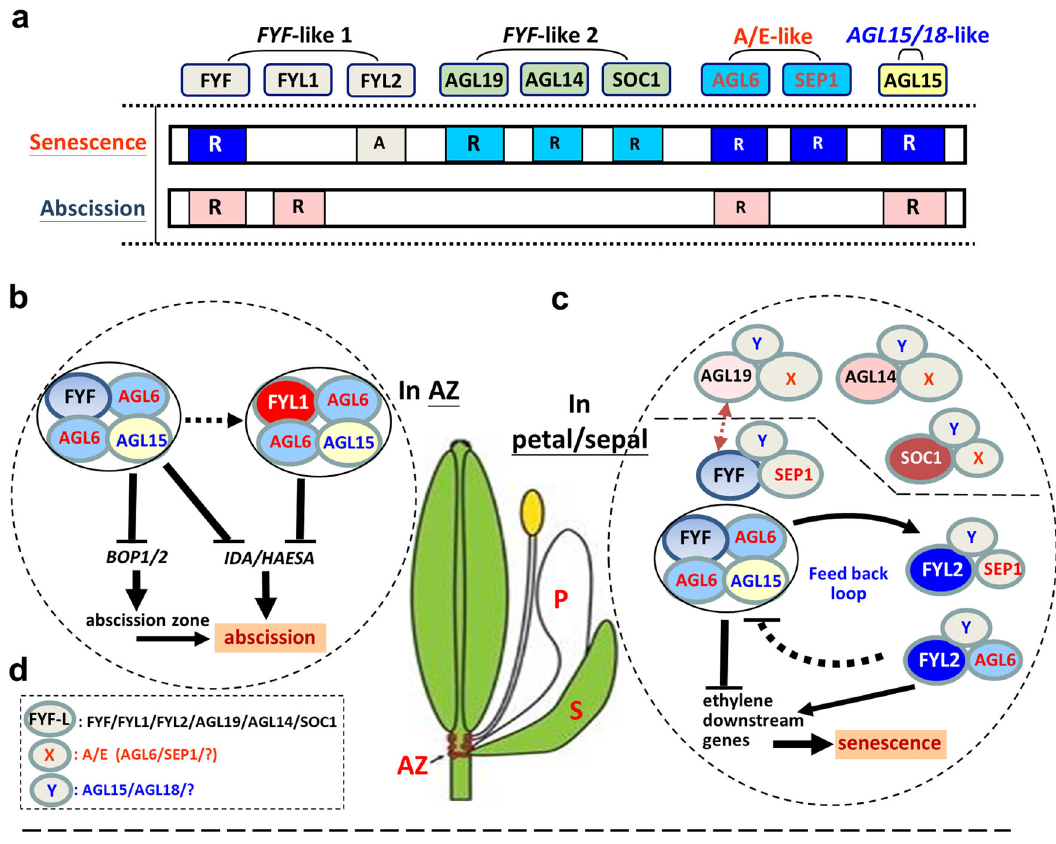
Fig. 5 The functional evolution and regulatory network of the FYF -like genes in regulating fl ower senescence/abscission. a In Arabidopsis , six FYF -like genes in two subgroups ( FYF/FYL1/FYL2 and AGL19/AGL14/SOC1 ) were all involved in regulating fl ower senescence and/or abscission. In the FYF subgroup, FYF acts as a repressor (R) in suppressing both fl ower senescence (indicated by a blue box) and abscission (indicated by a pink box), and FYL1 acts as a repressor (R) and only suppresses fl ower abscission (indicated by a pink box). FYL2 functions as an activator (A) in promoting fl ower senescence (indicated by a gray box). In the SOC1 subgroup, AGL19, AGL14, and SOC1 function as repressors (R) and have only one function in suppressing fl ower senescence (indicated by a light blue box), with the effect of AGL19 being stronger than that of AGL14/SOC1 . In addition, the A/E functional genes AGL6/ SEP1 and AGL15/18 -like gene AGL15 (as a repressor) can regulate senescence (indicated by a blue box) by interacting with FYF/FYL2, whereas AGL6 and AGL15 can also regulate abscission (indicated by a pink box) by interacting with FYF/FYL1. The size of the letter R in the box correlated with the strength of the repressor for the MADS box proteins. b In the AZ of the perianth, FYF and FYL1 complement each other by forming two identi fi ed heterotetrameric abscission complexes, FYF/AGL6/AGL6/AGL15 and FYL1/AGL6/AGL6/AGL15, suppressing fl ower abscission through the downregulation ( ⊣ ) of BOP1/2 and IDA/HAESA expression. c In sepals/petals, FYF, AGL19, AGL14, and SOC1 functioned antagonistically to FYL2 in suppressing fl ower senescence. An identi fi ed FYF/AGL6/AGL6/AGL15 together with FYF/SEP1/Y, AGL19/X/Y, AGL14/X/Y, and SOC1/X/Y heterotetrameric senescence complexes suppressed sepal/petal senescence through the downregulation ( ⊣ ) of ethylene downstream gene expression. In contrast, FYL2/AGL6/Y and FYL2/SEP1/Y heterotetrameric complexes promoted sepal/petal senescence by the activation ( → ) of ethylene downstream gene expression, possibly through a negative feedback loop to FYF/X/Y, AGL19/X/Y, AGL14/X/Y, and SOC1/X/Y. d In these cases from ( c ), the heterotetrameric complexes are composed of FYF-like, X (in red) and Y (in blue) proteins. FYF-like can be either one of the FYF/FYL1/FYL2/AGL19/AGL14/SOC1, X can be AGL6, SEP1, or any unidenti fi ed A/E proteins, whereas Y can be AGL15, AGL18, or any unidenti fi ed AGL15/18-like CaMV 35S promoter and used for plant transformation. Sequences for the primers PCR ampli fi cation. The IDA promoter and the cDNA for FYL1 were subcloned are listed in the Supplementary Table 1. into the modi fi ed binary vector pEpyon-12K 1 . Sequences for the primers are listed in Supplementary Table 1. Cloning of the promoter DNA fragment from Arabidopsis . For the FYL1:: GUS and FYL2:: GUS constructs, the promoter regions which included the 5 ′ UTR and fi rst intron for FYL1 (2.65 kb) and FYL2 (2.43 kb) were obtained by PCR ampli- fi cation using speci fi c primer pairs from the genomic DNA followed by cloning into the pGEM-T easy vector (Promega, Madison, WI, USA). These promoter fragments were then subcloned into the linker region before the β -Glucuronidase (GUS) coding region in the binary vector pEpyon01k 1,2 . For the AGL6:: GUS , AGL15:: GUS , AGL19:: GUS, and SOC1:: GUS constructs, the promoter regions which included the 5 ’ UTR and fi rst intron for AGL6 (4.96 kb), AGL15 (0.94 kb), AGL19 (4.59 kb) and SOC1 (5.68 kb) were obtained by PCR ampli fi cation and these promoter fragments were subcloned into the linker region before the β - Glucuronidase (GUS) coding region in the binary vector pEpyon01k in the same manner as FYL1/2:: GUS . Sequences for the primers are listed in Supplementary Table 1. For the IDA:: FYL1 construct, the IDA promoter (1.43 kb) was obtained by PCR ampli fi cation as described previously 1 . The cDNA for FYL1 was obtained by